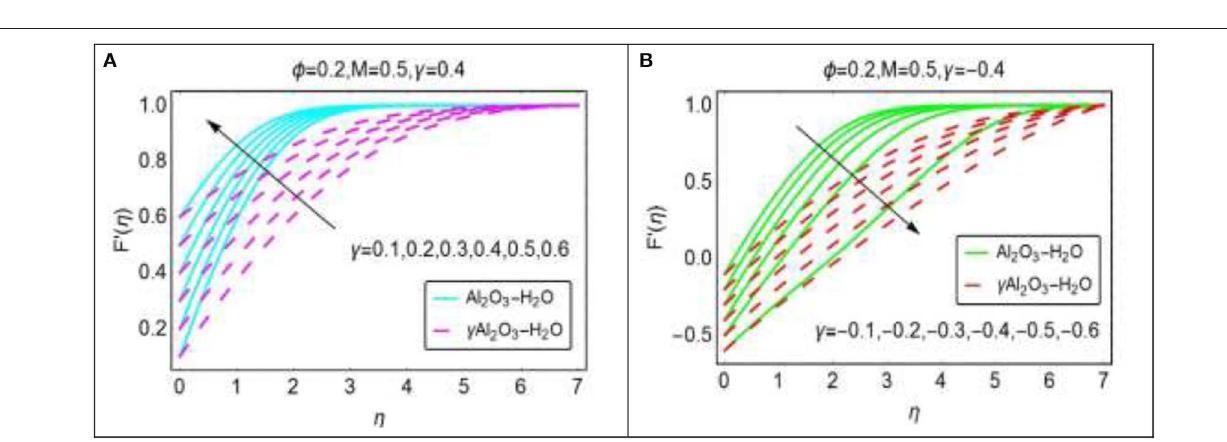
FIGURE 3 | The effects of (A) γ positive, (B) γ negative on dimensionless φ on dimensionless velocity F ′ ( η ).